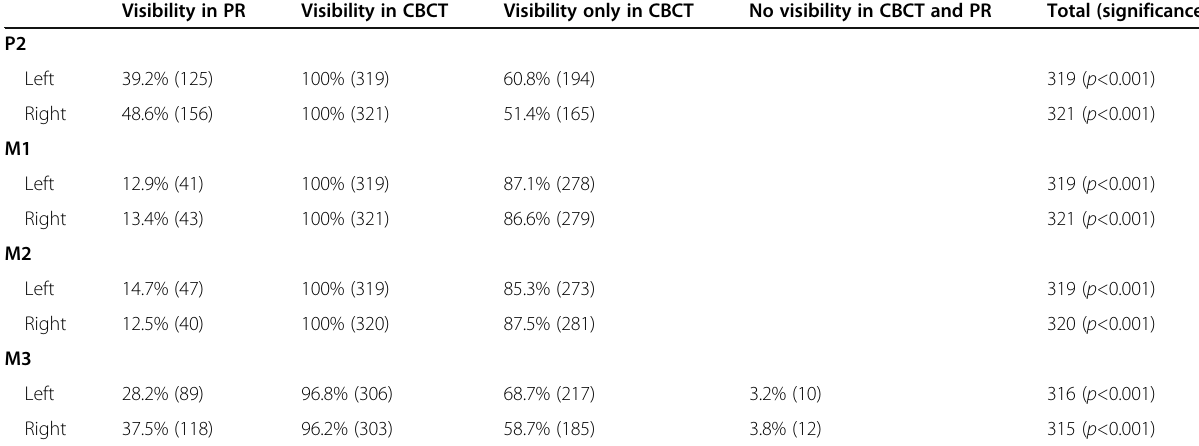
Table 1 Visibility of the roof of the CM in the PR versus